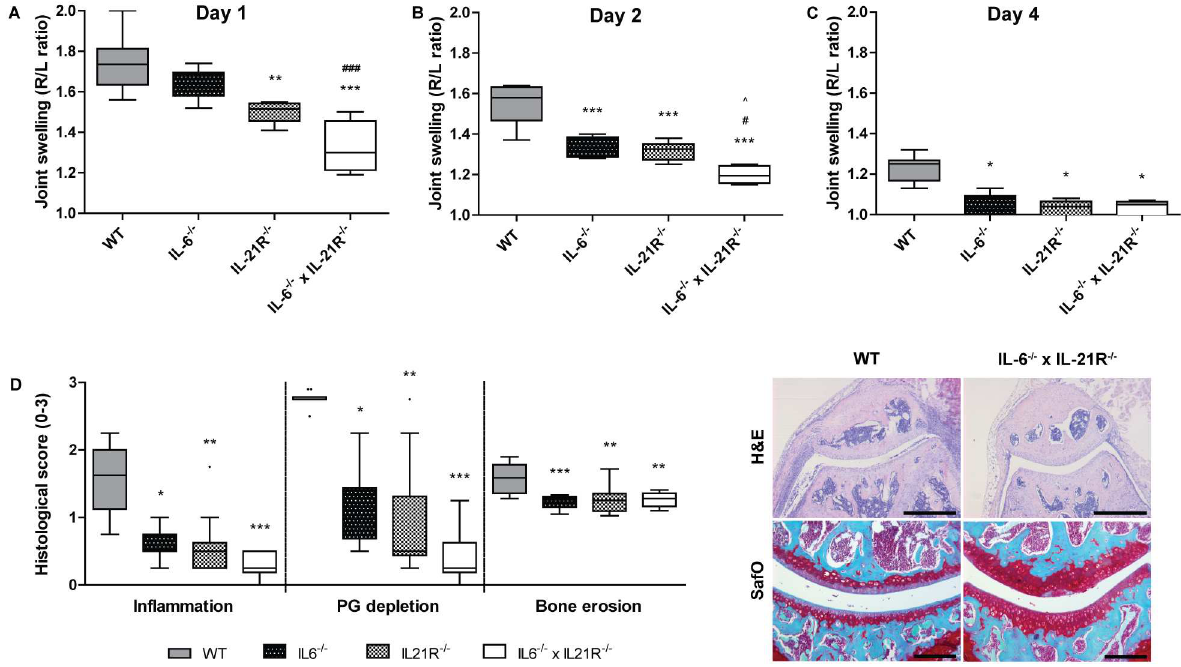
Fig 3. Antigen-induced arthritis severity is potently reduced by combinatorial blockade of IL-6 and IL-21 signaling pathways. Joint swellingof WT, IL-6 -/- , IL-21R -/- , and IL-6 -/- x IL-21R -/- mice at day 1 (A), day 2 (B), and day 4 (C) after arthritis induction, depictedas ratio betweenright and left knee joint, measuredby 99m Technetiumpertechnetate uptake in the joint (n = 6/group). Histologically scored inflammation, bone erosion (both H&E staining, scale bar 500 μ M), and cartilageproteoglycan depletion(SafO staining, scale bar 200 μ M) (D; n = 10/group). * p < 0.05, ** p < 0.01, *** p < 0.001versus WT; # p < 0.05, ### p < 0.001versus IL-6 -/- ; ^p < 0.05versus IL-21R -/- ; A+B One- way ANOVA, C+D Kruskal-Wallis.